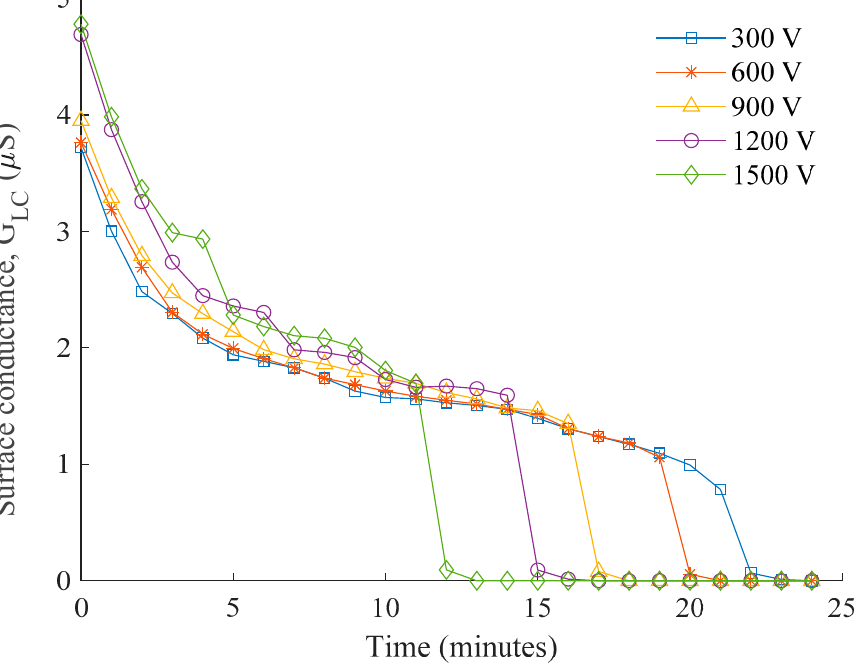
Figure 8. The plot of surface conductance for different energization voltages during the testing period.